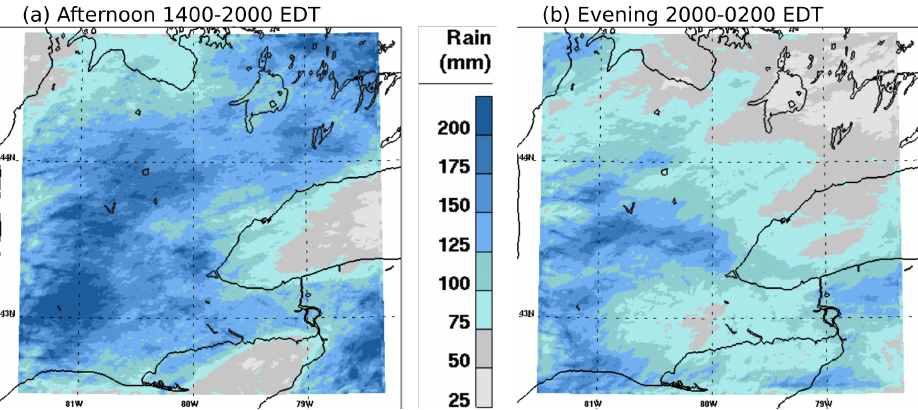
Figure 11. Six hour precipitation accumulation (mm) for the period 13 May–31 August 2015 for TOR-GEM250 valid for ( a ) early afternoon between 1400 and 2000 EDT and ( b ) evening and early night between 2000 to 0200